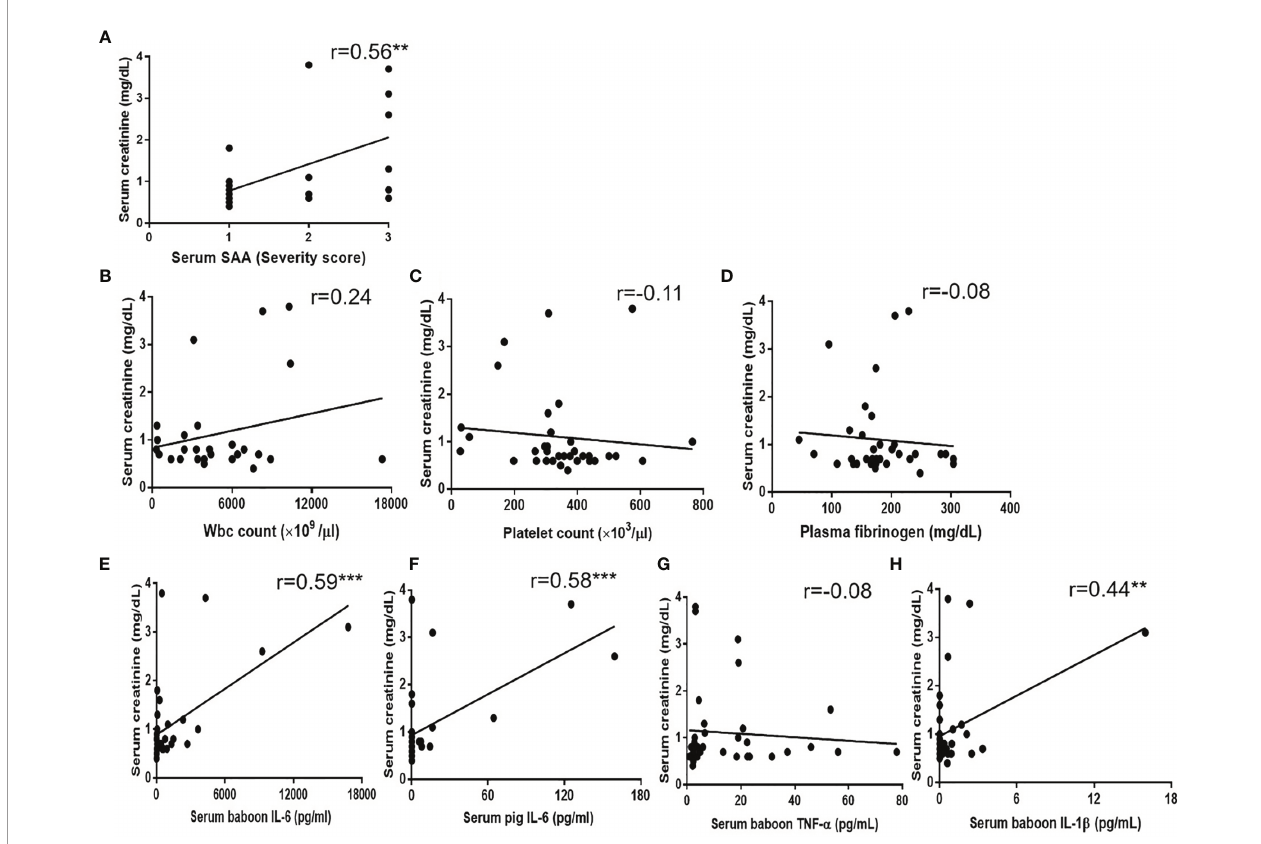
FIGURE 5 | Correlations between serum creatinine with (A) SAA score, (B) WBC count, (C) platelet count, (D) plasma fi brinogen, (E) serum baboon IL-6, (F) serum pig IL-6, (G) serum TNF- a , (H) serum IL-1 b . Signi fi cant positive correlations were found between serum creatinine and SAA score (**p < 0.01), serum baboon IL-6 (***p < 0.001), serum pig IL-6 (***p < 0.001) or serum IL-1 b (**p <